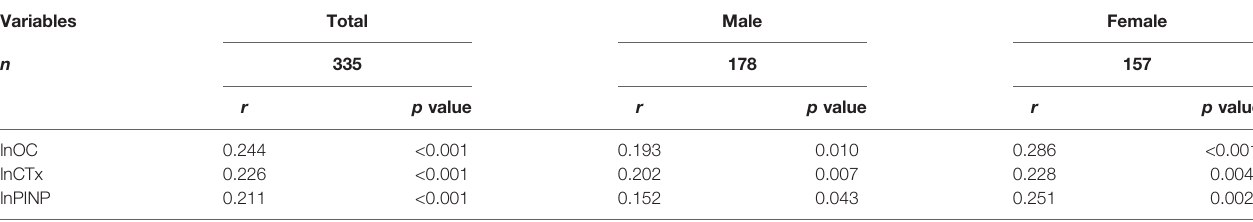
TABLE 2 | Relationships between the LDL-C/Apo B ratio and BTMs.